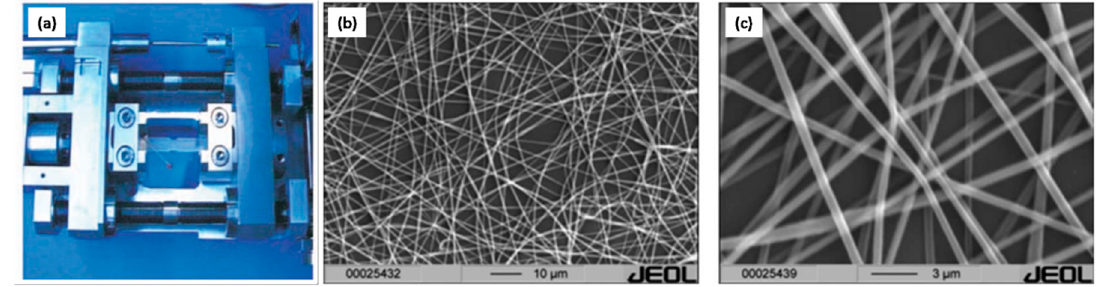
Figure 6. ( a ) Experiment setup of electrospinning technique and SEM images of PS-NFs, ( b , c ) in lower and larger magnification.